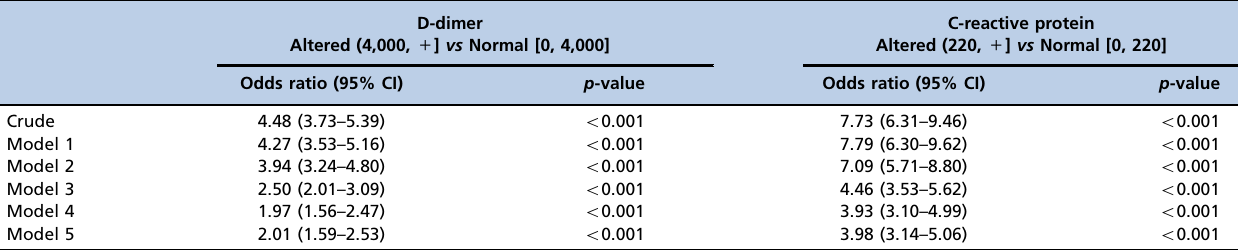
Table 5 (cost components) indicates the relevant direc-